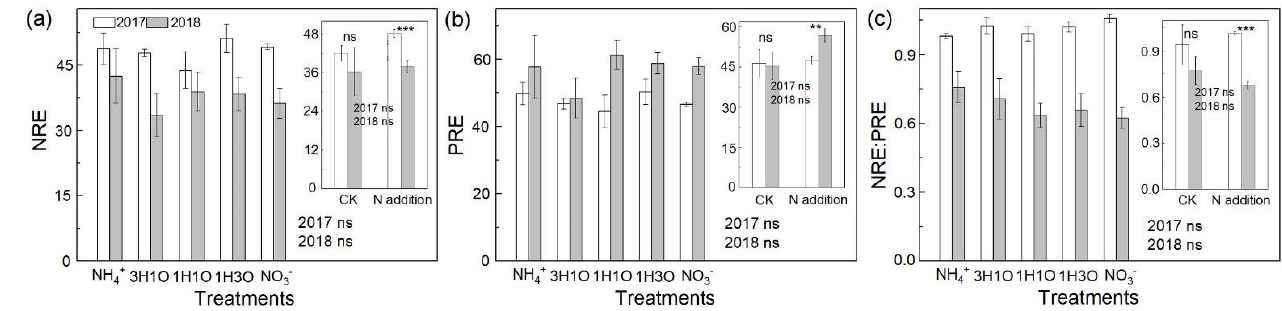
Figure 5. Response of leaf nutrient resorption efficiencies (including NRE ( a ), PRE ( b ), NRE:PRE ( c )) to various N form fertilizations. The asterisks and ns above the white and gray bar graphs represent the significance between 2017 and 2018. The asterisks and ns following the number of years inside the little figure represent the significance in control ( n = 4) and N addition (average, n = 20). The asterisks and ns following the number of years outside the figure represent the significance between N addition groups. * p < 0.05; ** p < 0.01; *** p < 0.001; ns, not significant.